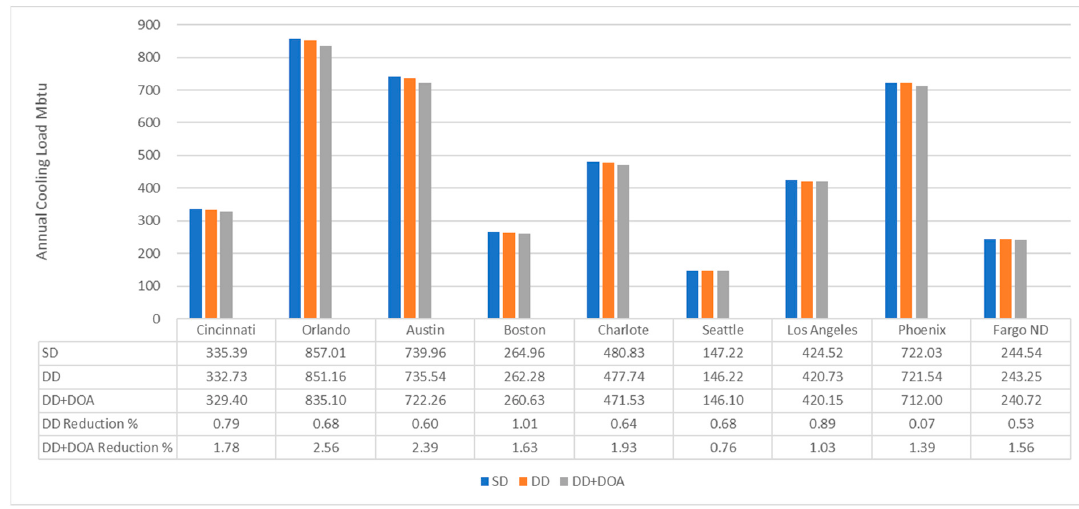
Figure 8. Annual cooling loads for three cases and reduction by using the proposed system.